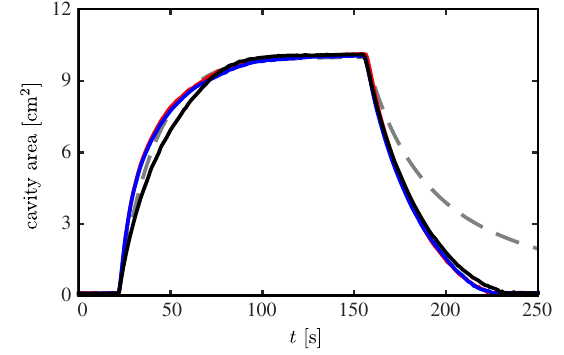
FIG. 7. Same as Fig. 2(a) but without the 12 s offset. The second and third cycles (blue and red curves) and the model (dashed gray curve) agree very well during cavity expansion, but the model relaxes more slowly than the experiment. The first cycle of the experiment (black) is somewhat different due to heterogeneities in the initial